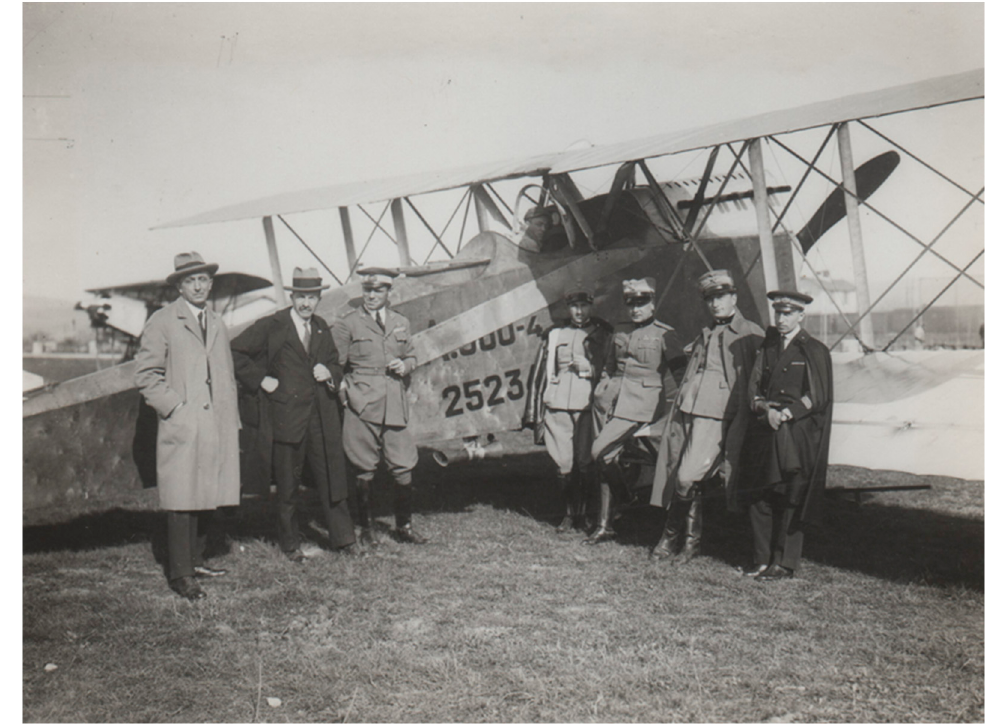
Figure 1. In the years between the 19 th and 20 th centuries, military and civilian health were collabo- rating side by side in the fight against the vector of malaria. In this picture, military and civilian Italian Health Authorities witness the diffusion by airplane of Paris green (the most widely used insecticide in that period) for malaria vector control in the countryside around Rome in 1928. (Courtesy of the Archive of the Istituto Superiore di Sanit à , Roma, Italia https://arch.iss.it/, accessed on 21 July